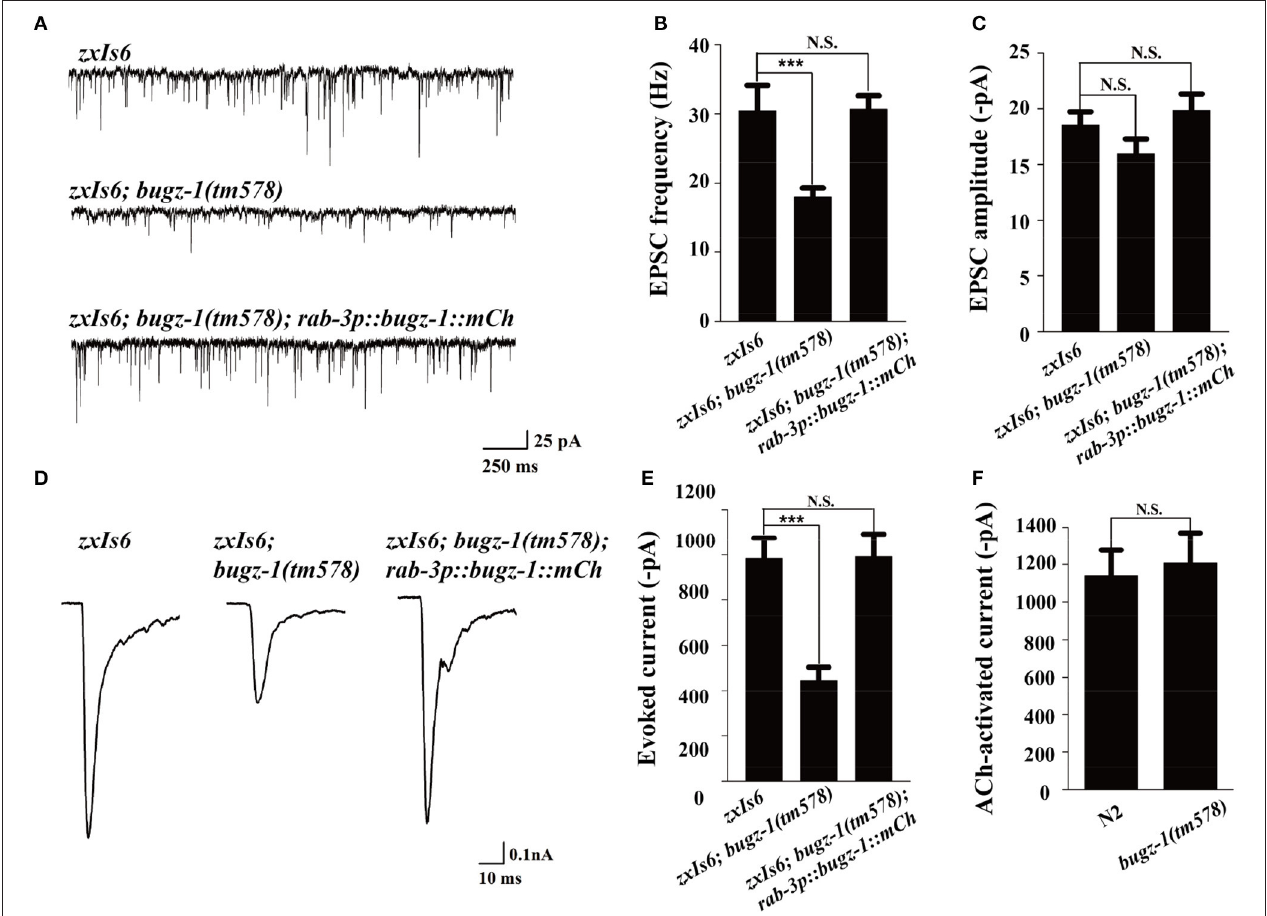
FIGURE 5 | BuGZ-1 regulates neurotransmitter release at NMJs. (A–C) Recording of endogenous excitatory postsynaptic currents (EPSC) from adult body wall muscles of the indicated genotypes. zxIs6 [unc-17p::chop-2(H134R)::yfp , lin-15( + )] . Representative traces (A) and summary data for endogenous EPSC frequency (B) and EPSC amplitude (C) are shown. n ≥ 15. (D,E) Recording of photo-evoked EPSCs from adult body wall muscles of the indicated genotypes. ChR2-expressing cholinergic motor neurons were photo-activated by 100 ms blue light. Representative traces (D) and summary data (E) are shown. n ≥ 10. (F) Acetylcholine-induced currents in body muscles of mutant were indistinguishable from wild type. n ≥ 10. For each genotype, independent experiments were carried out in different animals. Values that significantly differ from controls are indicated (*** p < 0.001 by two-tails Student’s t -test). N.S. indicates no significant difference from control. Error bars represent